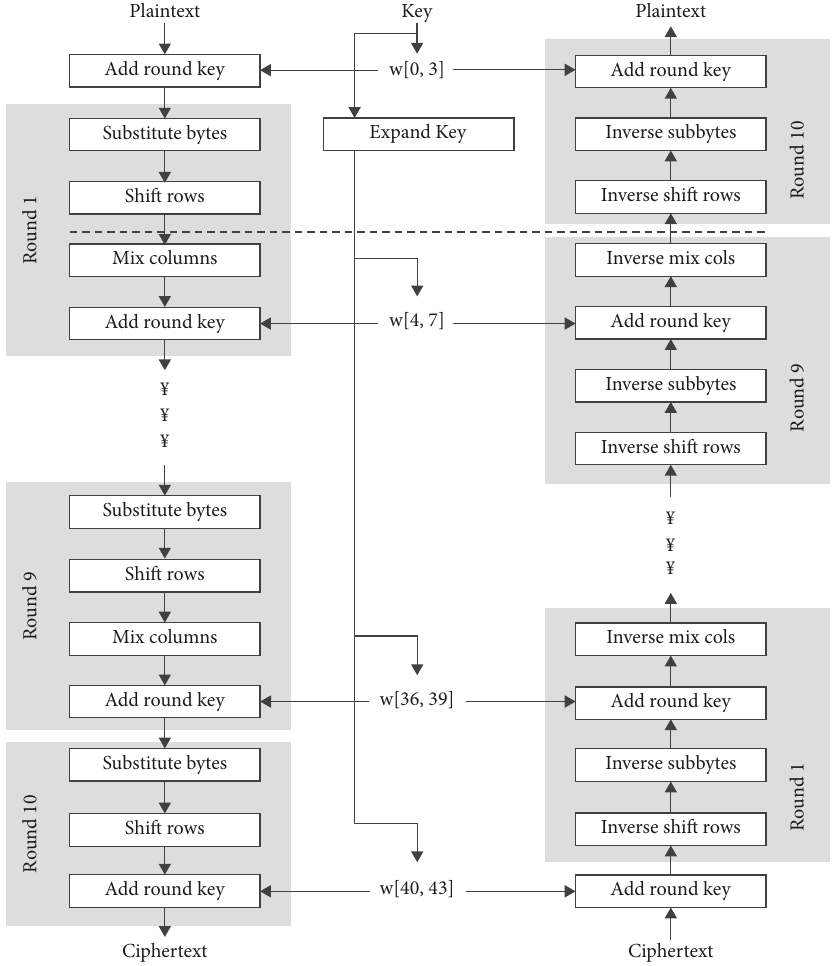
Figure 4: Step-by-step 10 round AES encryption and decryption [17].